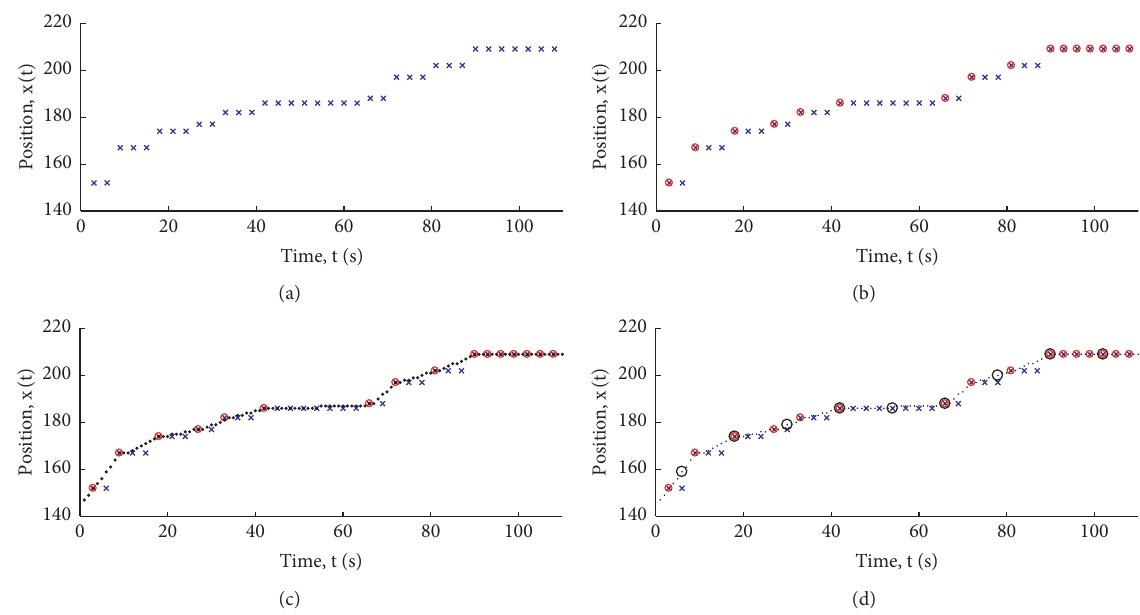
Figure 17: Illustration of the interpolation process done to filter out false occurrence of zero velocities. (a) Trajectory, x ( t ) of a single bus, collected at a time interval of 3 seconds. (b) Removing repeated data points which are not at bus stops. Red circles indicate the remaining points. (c) Black dots indicate the linear interpolation of the remaining points. (d) Black circles indicate the filtered data in an intended time resolution of δ t 12 s.